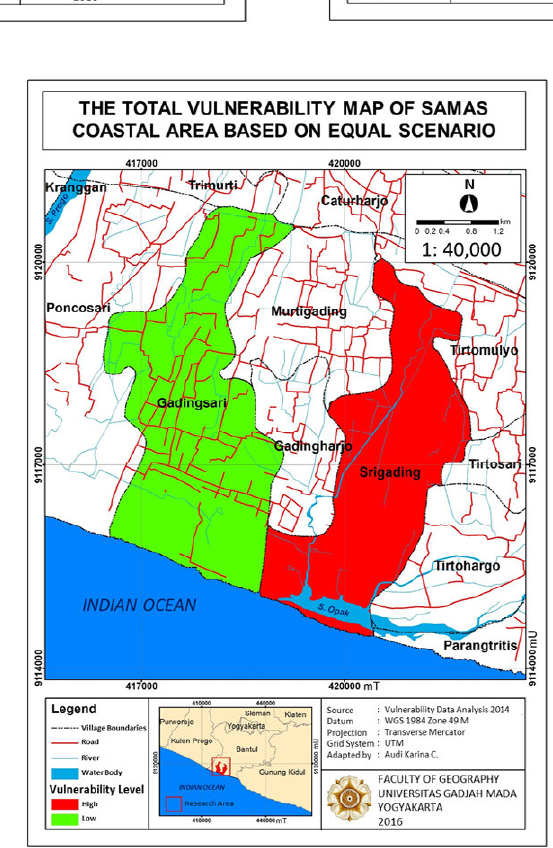
Fig. 4. Maps of total vulnerability with physical, socioeconomic, and equal scenarios by Choirunnisa